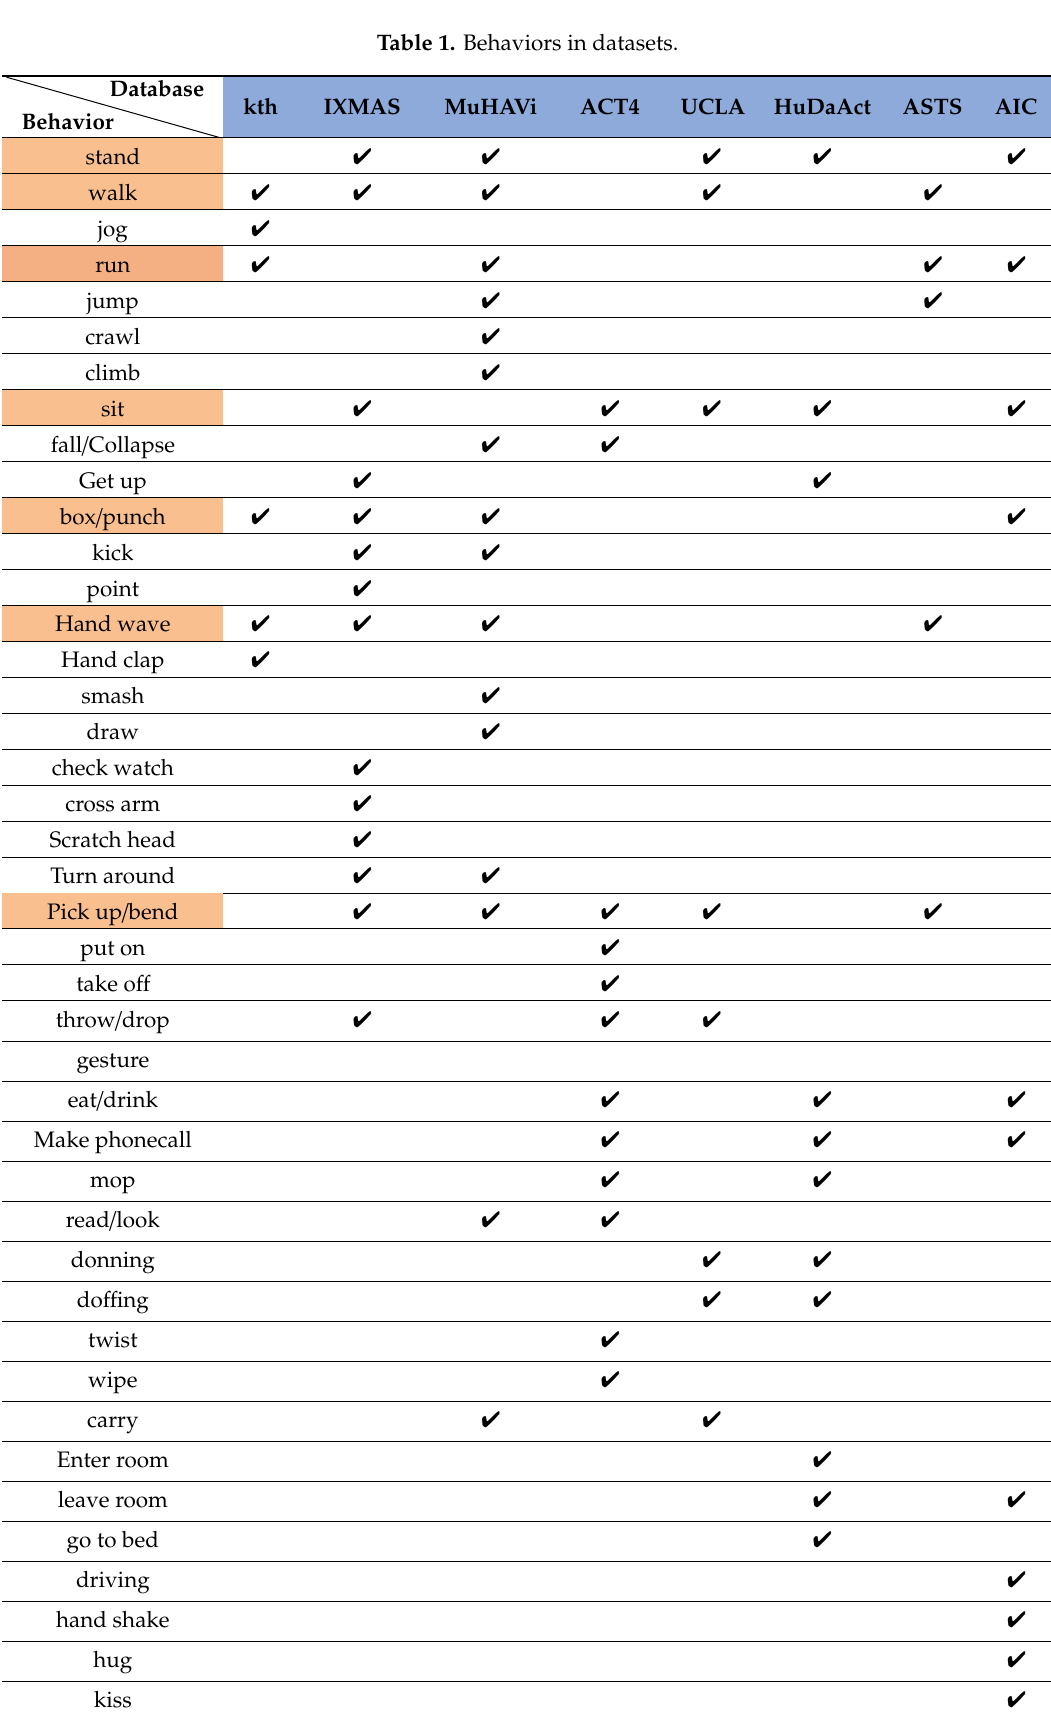
Table 1. Behaviors in